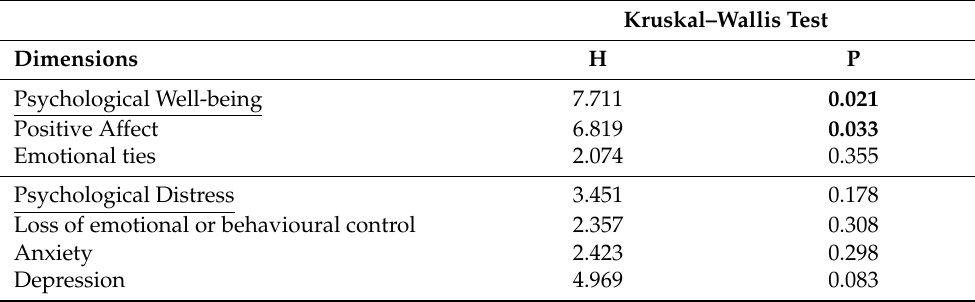
Table 1. Post-intervention Kruskal–Wallis test results for the mental health dimensions.